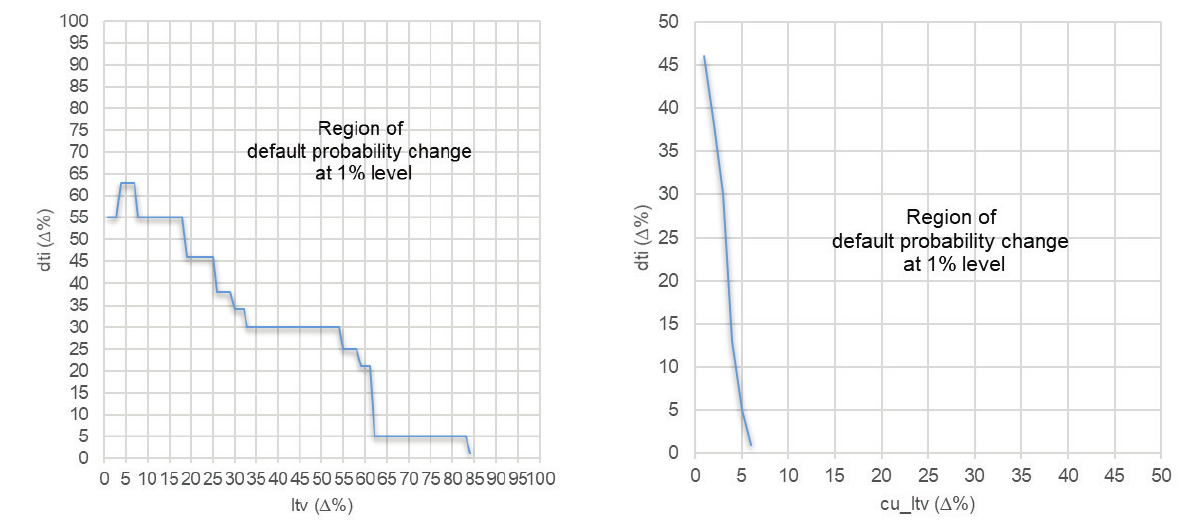
Figure 5. Changes in ME resulting from changes in original DTI (dti), and either original LTV (ltv) or current LTV (cu_ltv) in the RF model at the 1% signifi cance